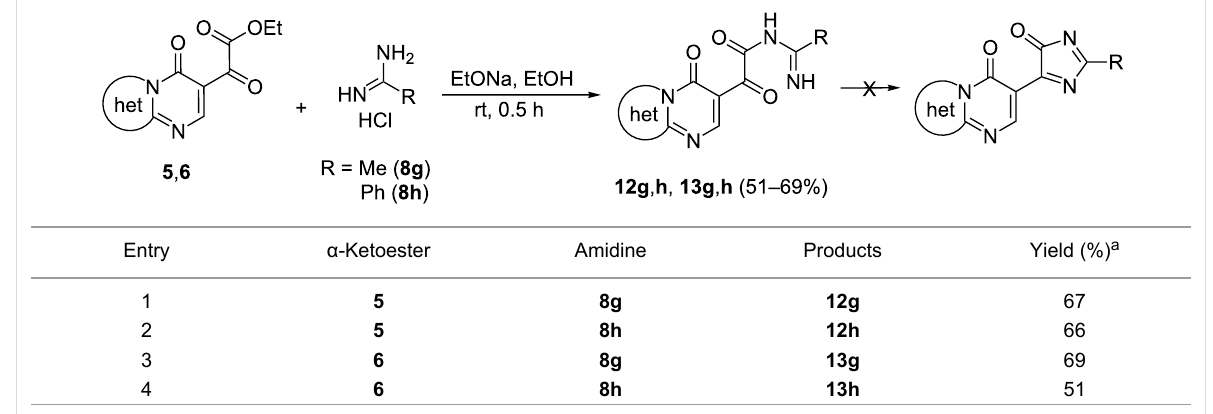
Table 9: Synthesis of compounds 12g , h and 13g , h .